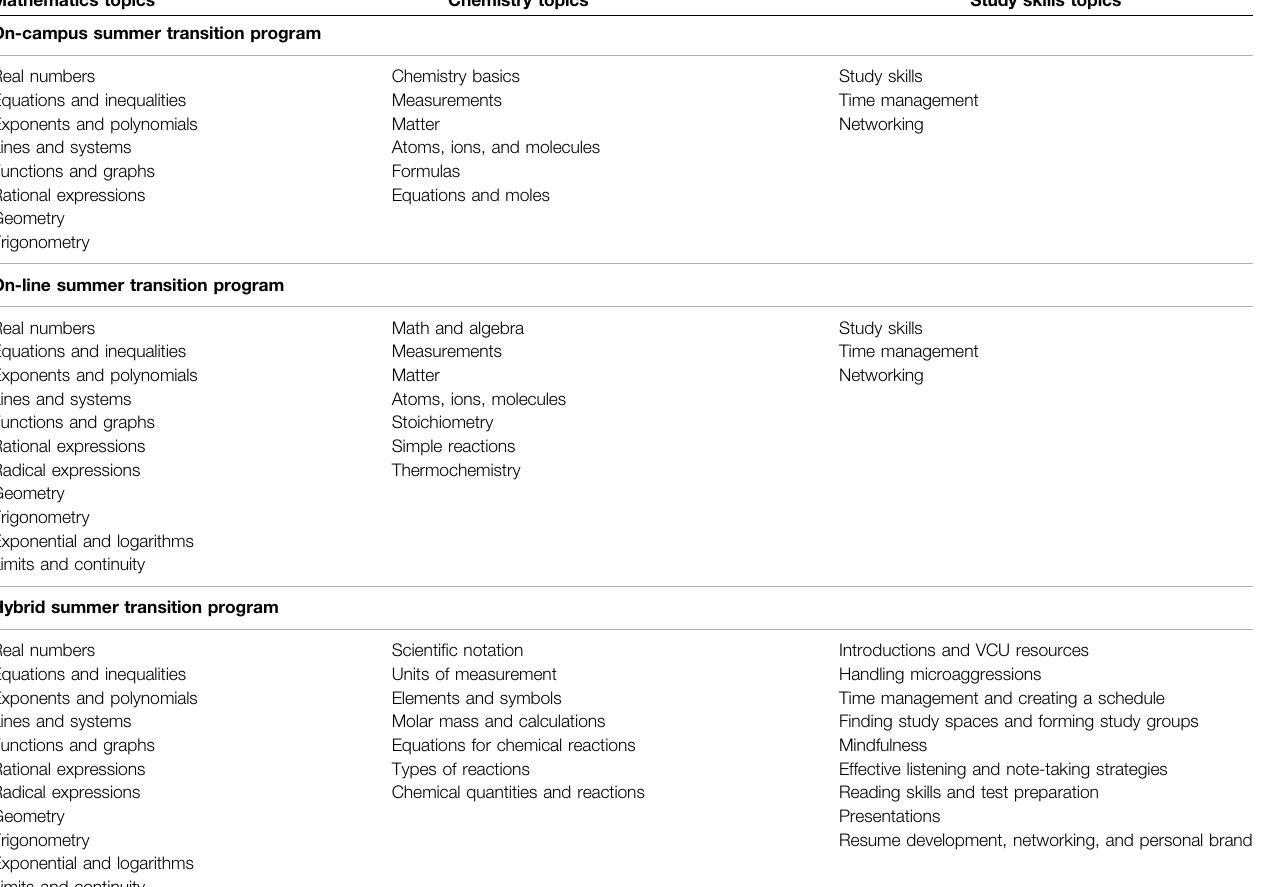
TABLE 1 | Summer Transition Program Topics for the varied modalities in which the program has been